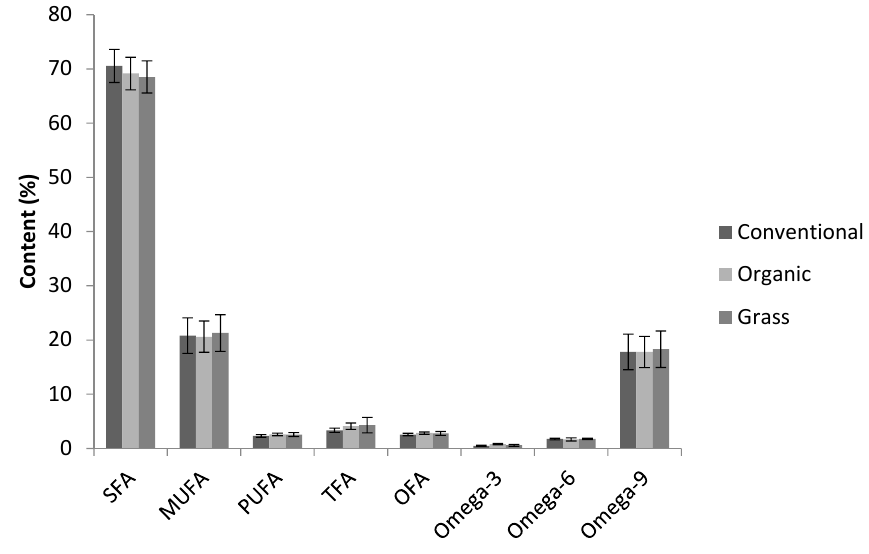
Figure 3. Comparing the contents of saturated fatty acids (SFA), monounsaturated fatty acids (MUFA), polyunsaturated fatty acids (PUFA), trans fatty acids (TFA), and other fatty acids (OFA) in conventional, organic, and grass butters. Error bars represent standard deviations.